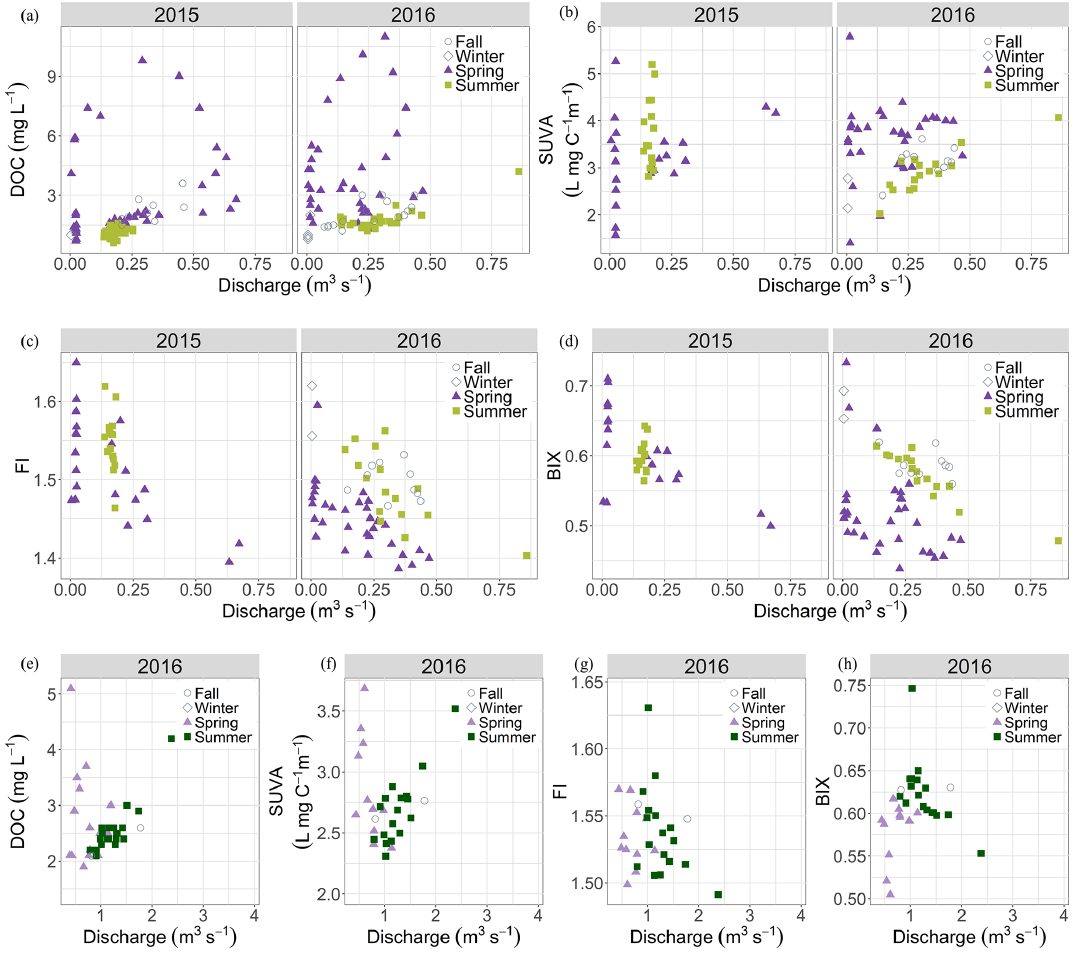
Figure 8. Concentration–discharge (C–Q) plots of the DOC concentration, SUVA, FI and HIX for GC (2015–2016) and WCO (2016). Panels (a) , (b) , (c) and (d) show the DOC concentration, SUVA254, FI and HIX optical indices in relation to discharge for 2015 and 2016 at Granger Creek (GC). Panels (e) , (f) , (g) and (h) show the same sets of concentration–discharge relationships for 2016 at Wolf Creek outlet (WCO). Season is indicated by shape and colour (purple/filled triangle – spring; green/filled square – summer; open circle – fall; open diamond – winter). The y axis values differ for each